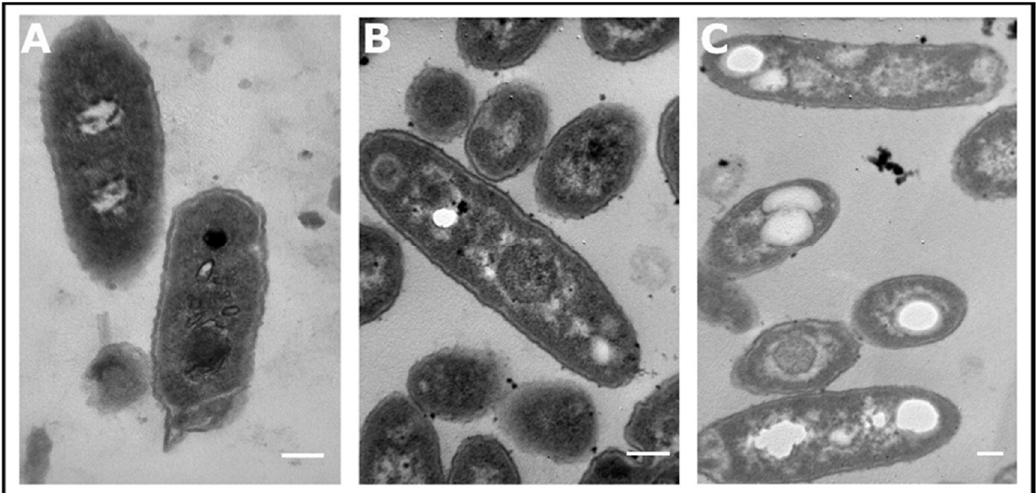
Figure 4. Transmission electron microscopy analyses of Pseudomonas sp. phDV1 cells grown for 72 h in M9 minimal medium in the presence of 200 mg/L ( A ), 400 mg/L ( B ) and 600 mg/L phenol ( C ). A and B : 20 k magnification; C : 12 k magnification. The bars correspond to 0.25 μ m.